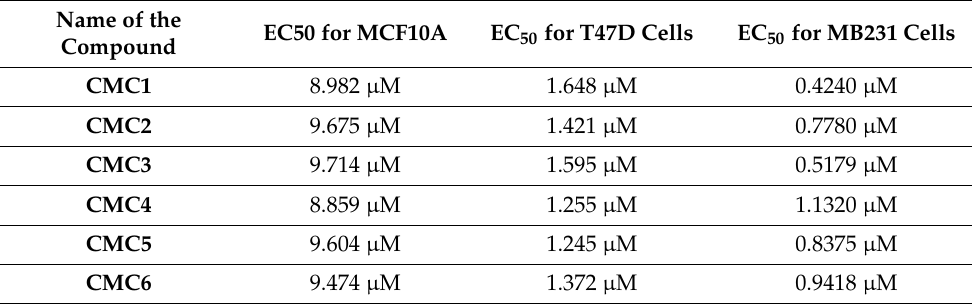
Figure 5. CUR and DCA inhibit cell viability and colony formation, to a lower extent, in human BC cells. ( A ) MTT, and ( B ) colony formation assays were carried out in MCF10A, T47D, and MB231 cells with CUR and DCA at different concentrations (0, 1, 5, and 10 μ M). Table 1. EC 50 values for CMC compounds were determined by a clonogenic survival assay for two human BC cell lines.